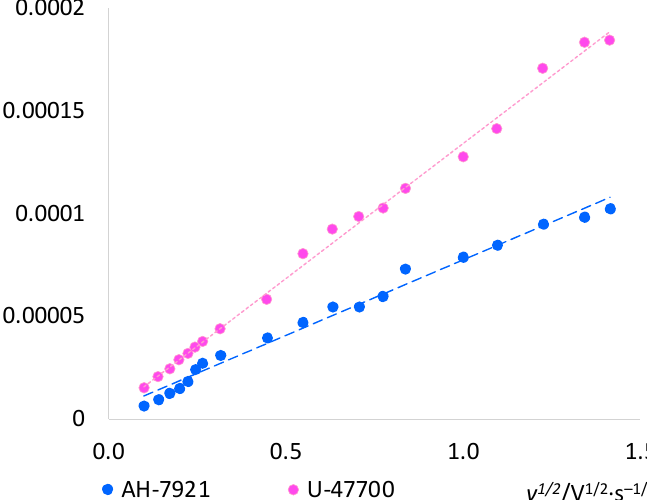
Figure 5. i vs. v 1/2 graph for the first voltammetric peak of U-47700 and for the first voltammetric peak of AH-7921. Equations are reported in Table 3.